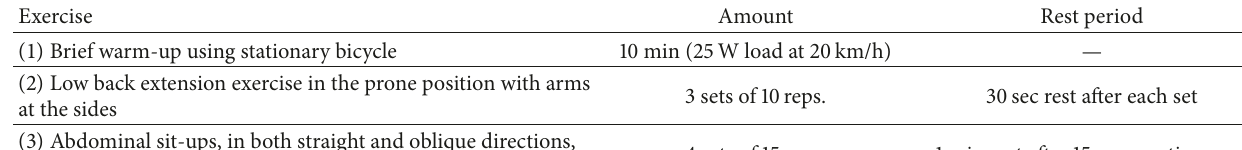
Table 2: Modified H¨olmich et al. protocol: part 2 (from the 3rd week